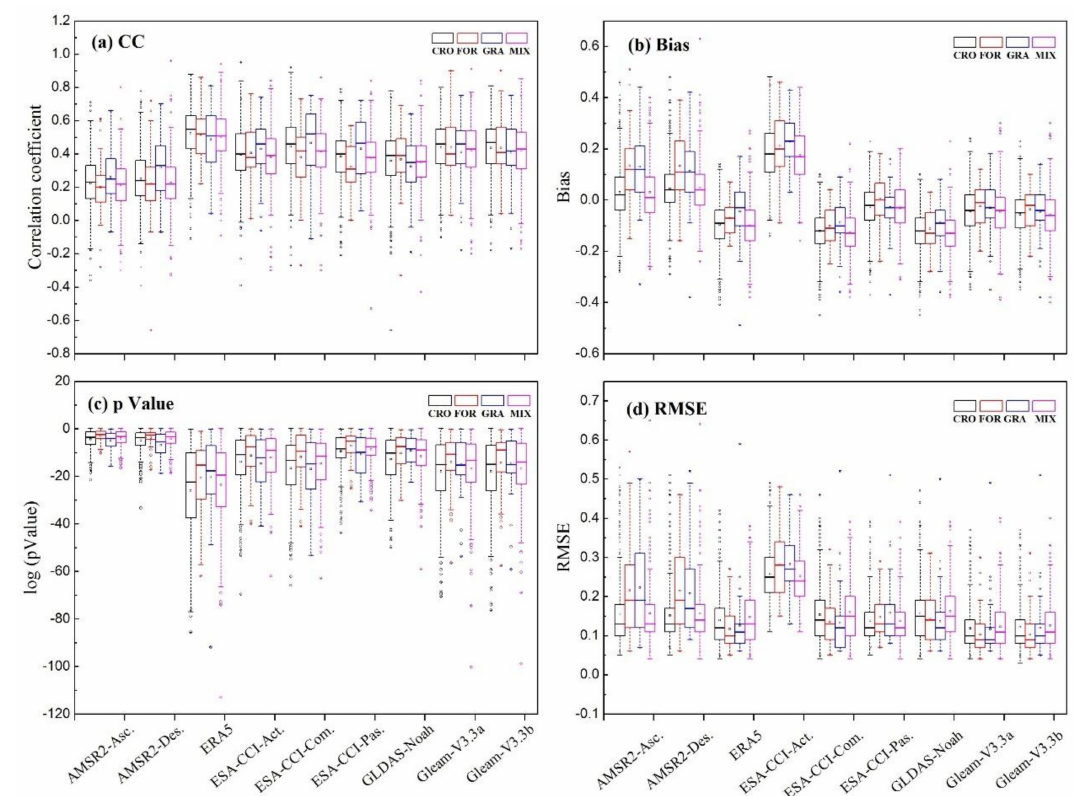
Figure 11. Performances of multi-source SM products under different land uses (e.g., CROpland, FORestland, GRAssland and MIX land). Herein, box diagrams have the same implications as the aforementioned statistical